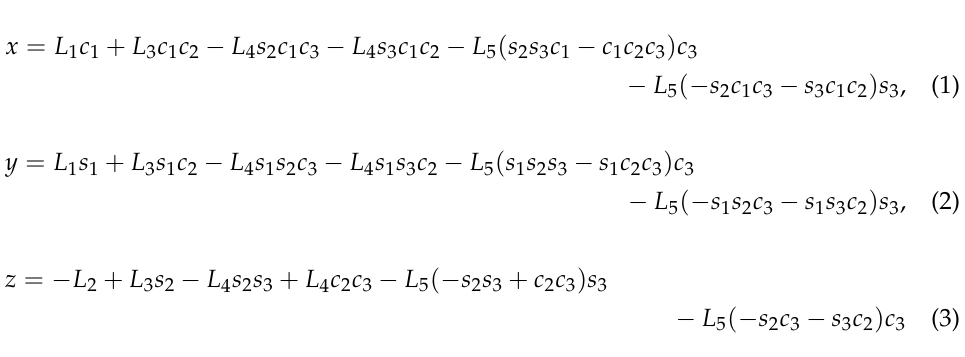
Figure 4. Link lengths and joints marked for the designed